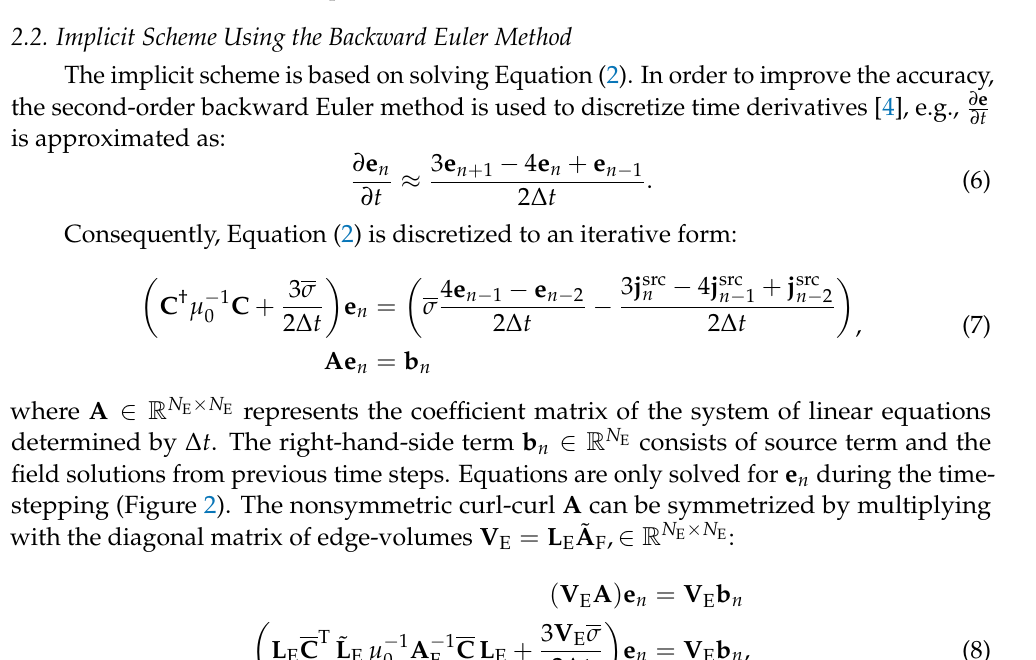
Figure 2. Sketch of time-stepping using the explicit scheme in the modified version of the Du Fort-Frankel method and the implicit scheme based on the second-order backward Euler